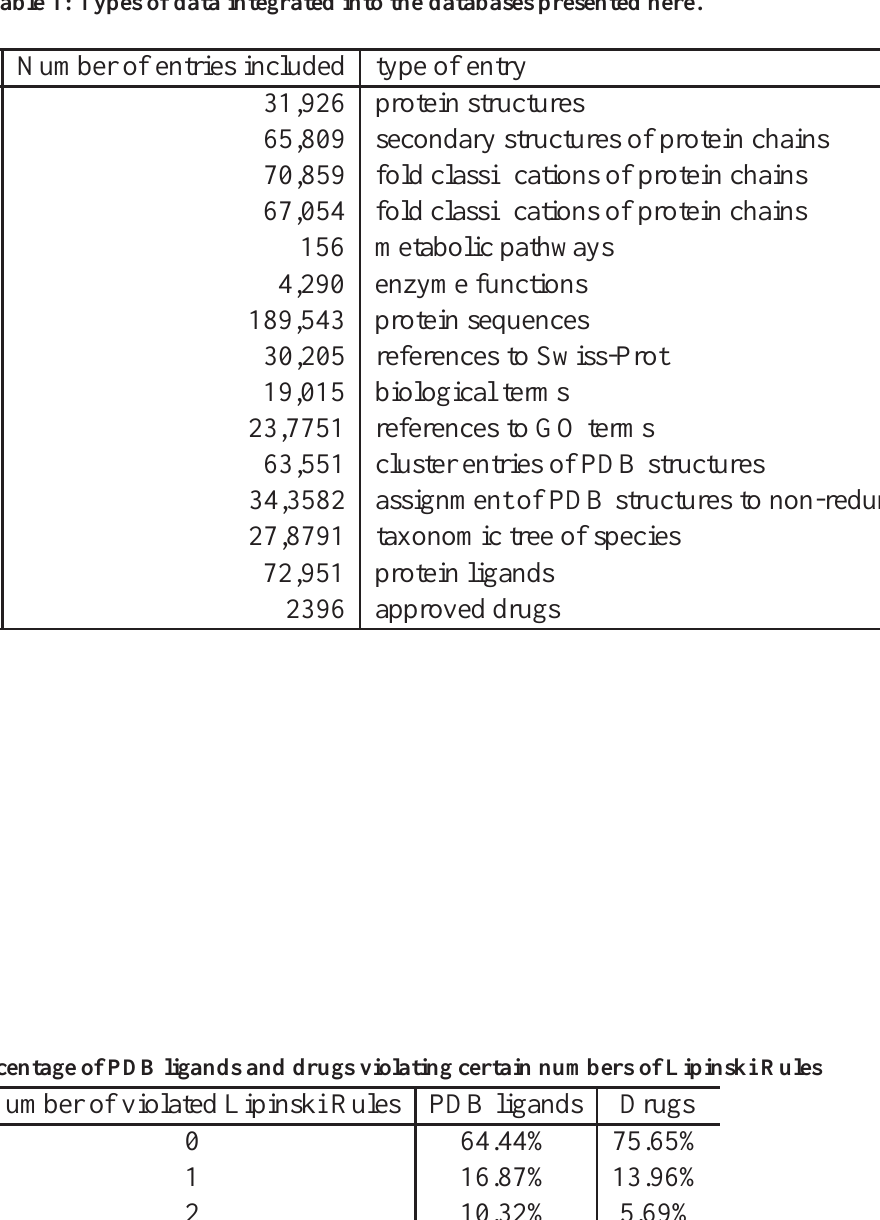
Table 1: Types of data integrated into the databases presented here.